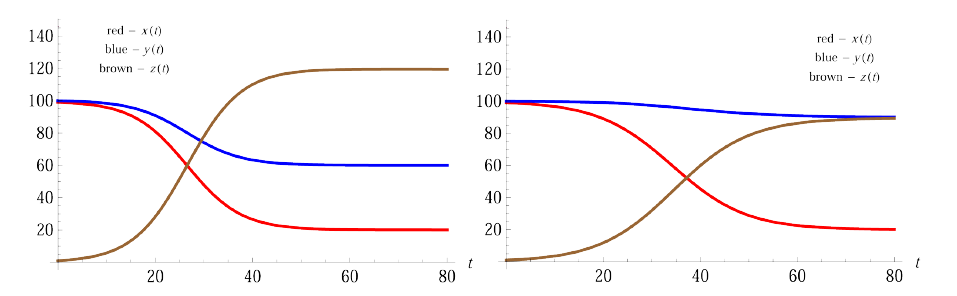
Figure 2. Time series of system (3): p = c vs. p < c ( a = 2 . 73973 · 10 − 6 , b = 0 . 03 , c = 0 . 0015 , d = 0 . 120047 , m = 0 . 0000328767 , n = 0 . 09; left: p = c = 0 . 0015, right: p = 0 . 001; initial conditions: x 0 = 99; y 0 = 100; z 0 = 1).